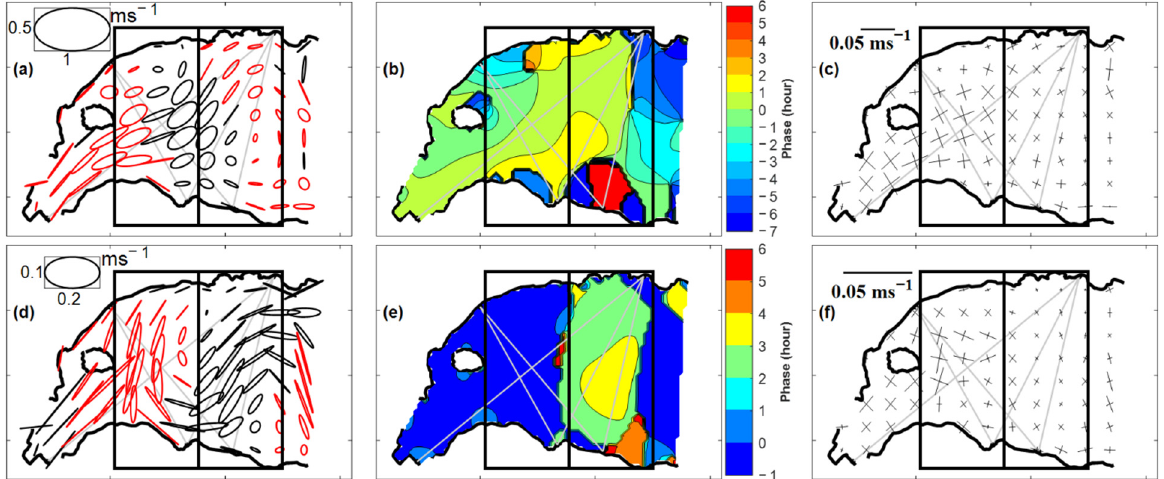
Figure 9. Tide ellipses and phases and the residuals for M 2 ( a – c ) and M 4 ( d – f ). The red and black circles indicate that the ellipse rotates in the clockwise and counterclockwise directions, respectively. The degree unit for the phase of M 2 and M 4 currents are converted into hour units.